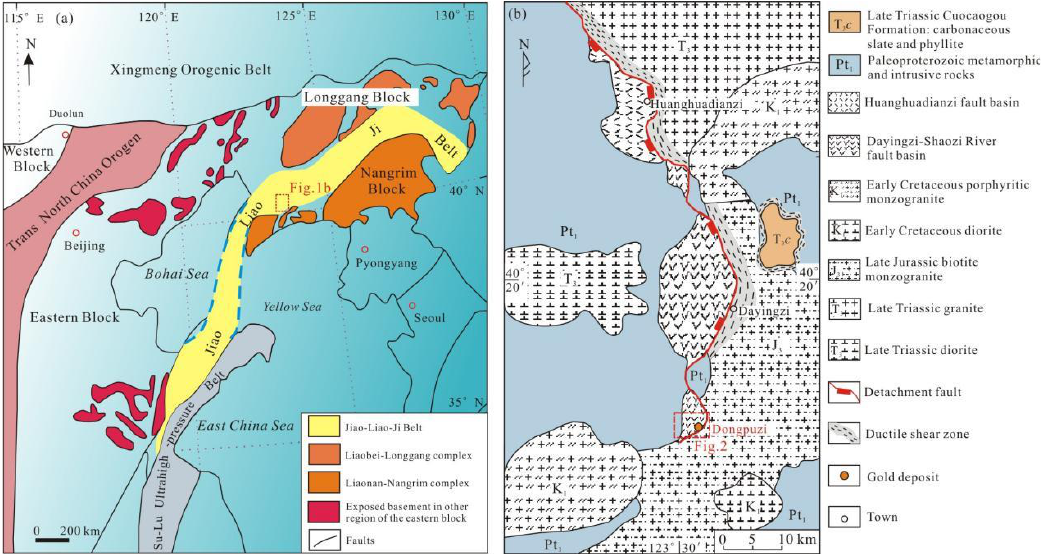
Figure 1. Geological and tectonic map of the eastern NCC ( a ), modified from [8]. A sketch map of the Huanghuadianzi – Dayingzi – Shaozi River area, Liaodong Peninsula ( b ), modified from [11]. The location of Figure 2 has been marked by a red rectangle.